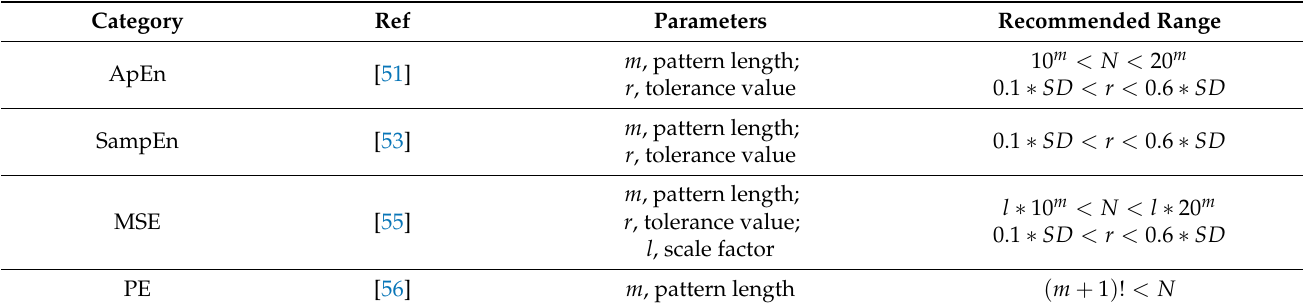
Table 2. Main entropy algorithms applied in the analysis of BOLD